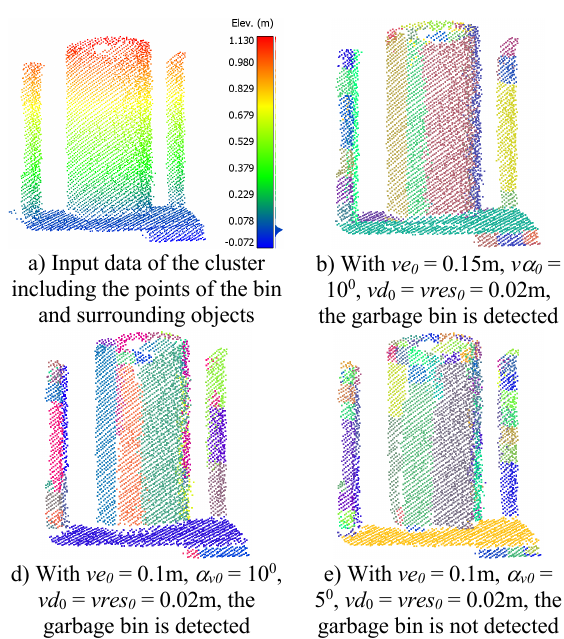
Figure 13 . Impact of parameters for VRG on plane extraction to detect public garbage